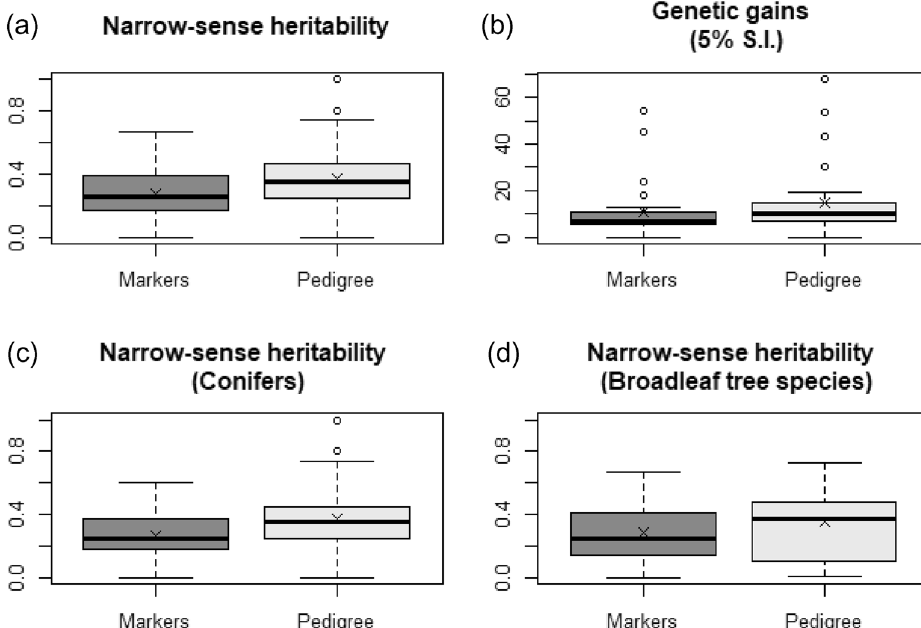
Figure 1. Pairwise comparisons between pedigree-based and marker-based estimates of ( a ) narrow-sense heritability ( h 2 ), ( b ) genetic gains in percentage (at 5% selection intensity, S.I.), and narrow-sense heritability ( h 2 ) for ( c ) conifers and ( d ) for broadleaf tree species. The symbol X represents the mean. The line in the box is the median. The box covers the first to the third quartiles. The dots are outliers, while the horizontal bars represent the minimum and the maximum values. Pedigree- and marker-based estimated genetic parameters and gains were significantly different based on the Wilcoxon matched-pairs signed-ranks